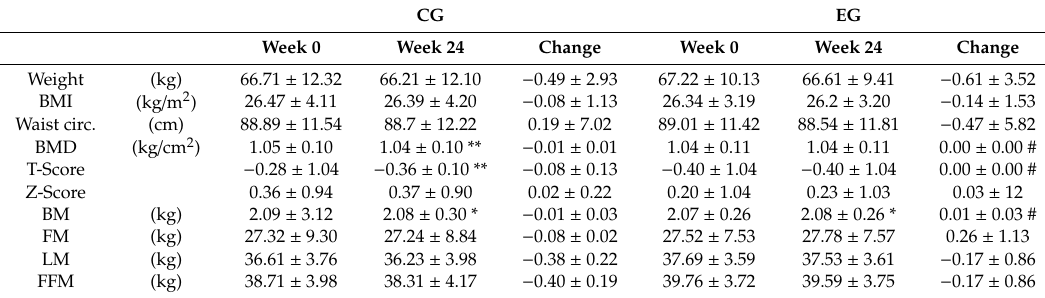
Table 4. Anthropometric parameters and body composition of the study participants before and after the intervention. CG